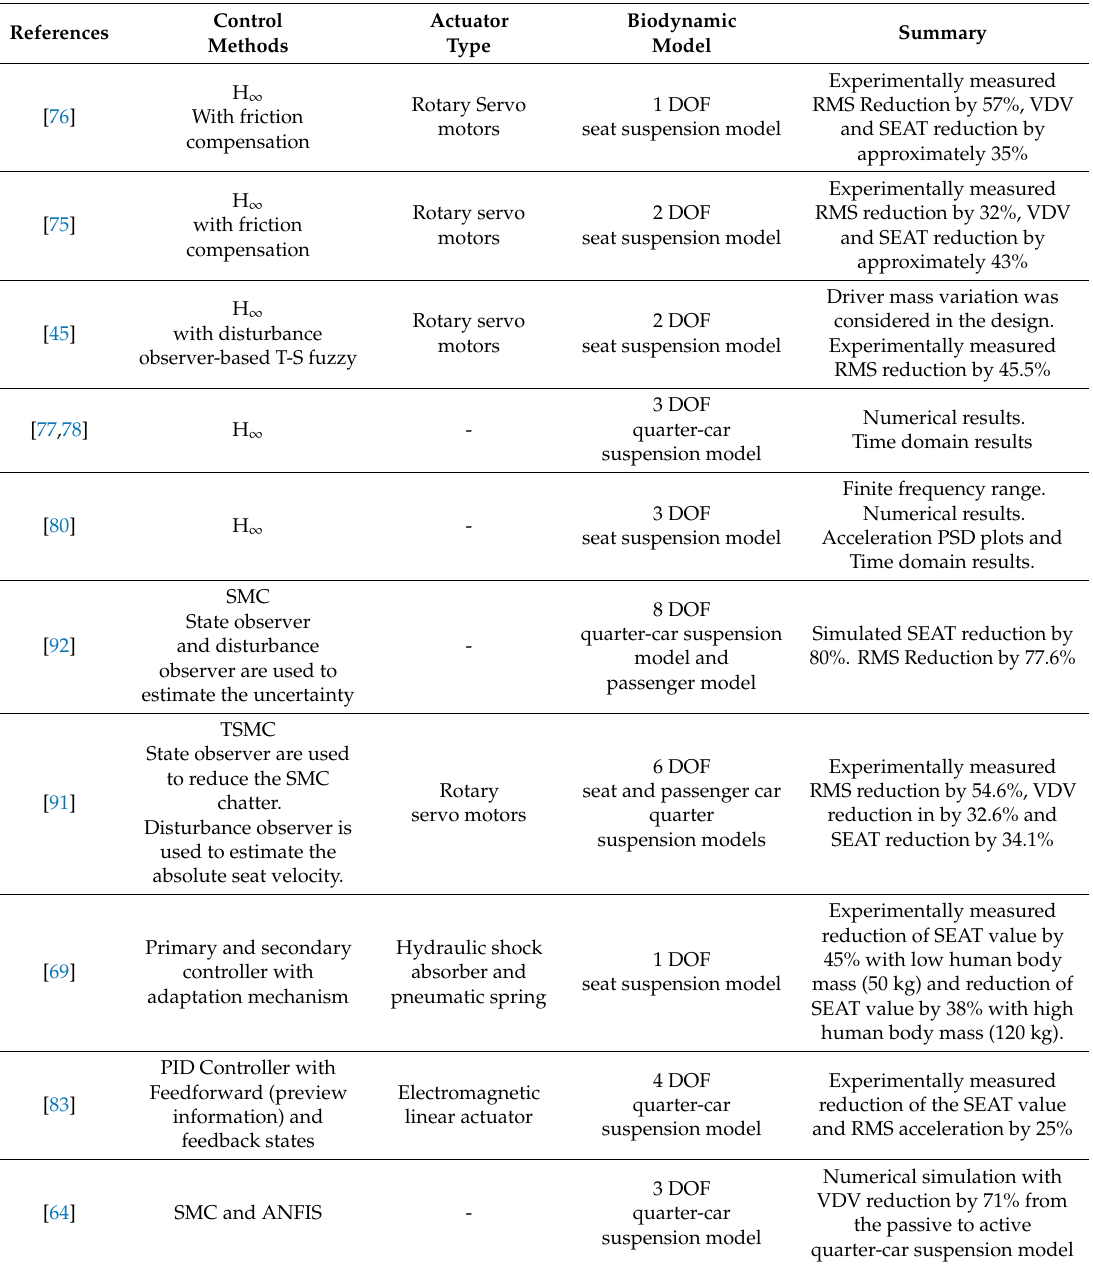
Table 3. Summary of recent work of active seat suspension control in the vertical vibration